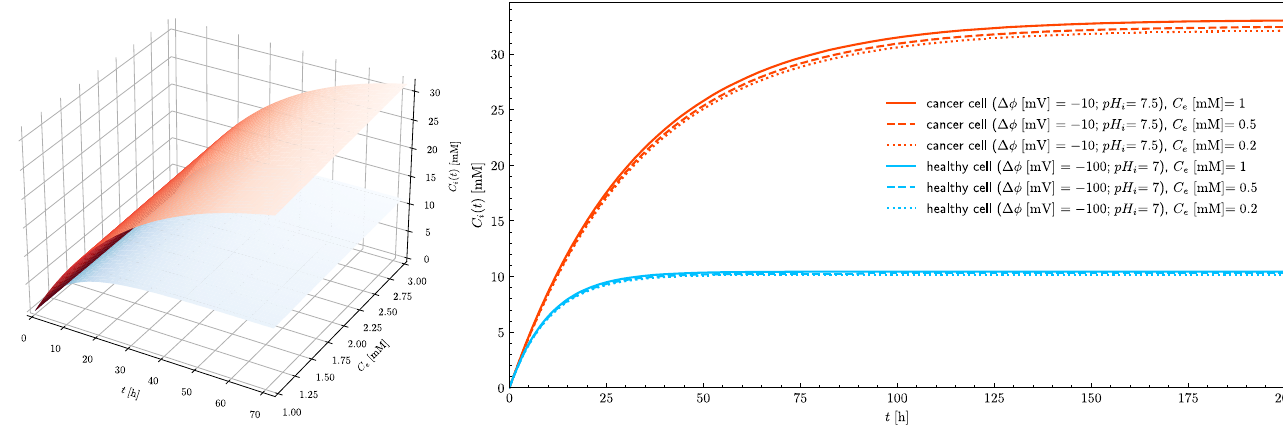
Figure 6. The effect of extracellular ascorbate concentration on the rise of the intracellular ascorbate concentration in time towards the steady-state value for healthy (blue) and cancer (red) cells (left panel). The right panel shows traces of intracellular ascorbate concentration as a function of time for healthy (blue traces) and cancer (red traces) cells. Traces show cases when extracellular ascorbate concentration equals 0.2, 0.5 and 1 mM for pH e = 7.4.